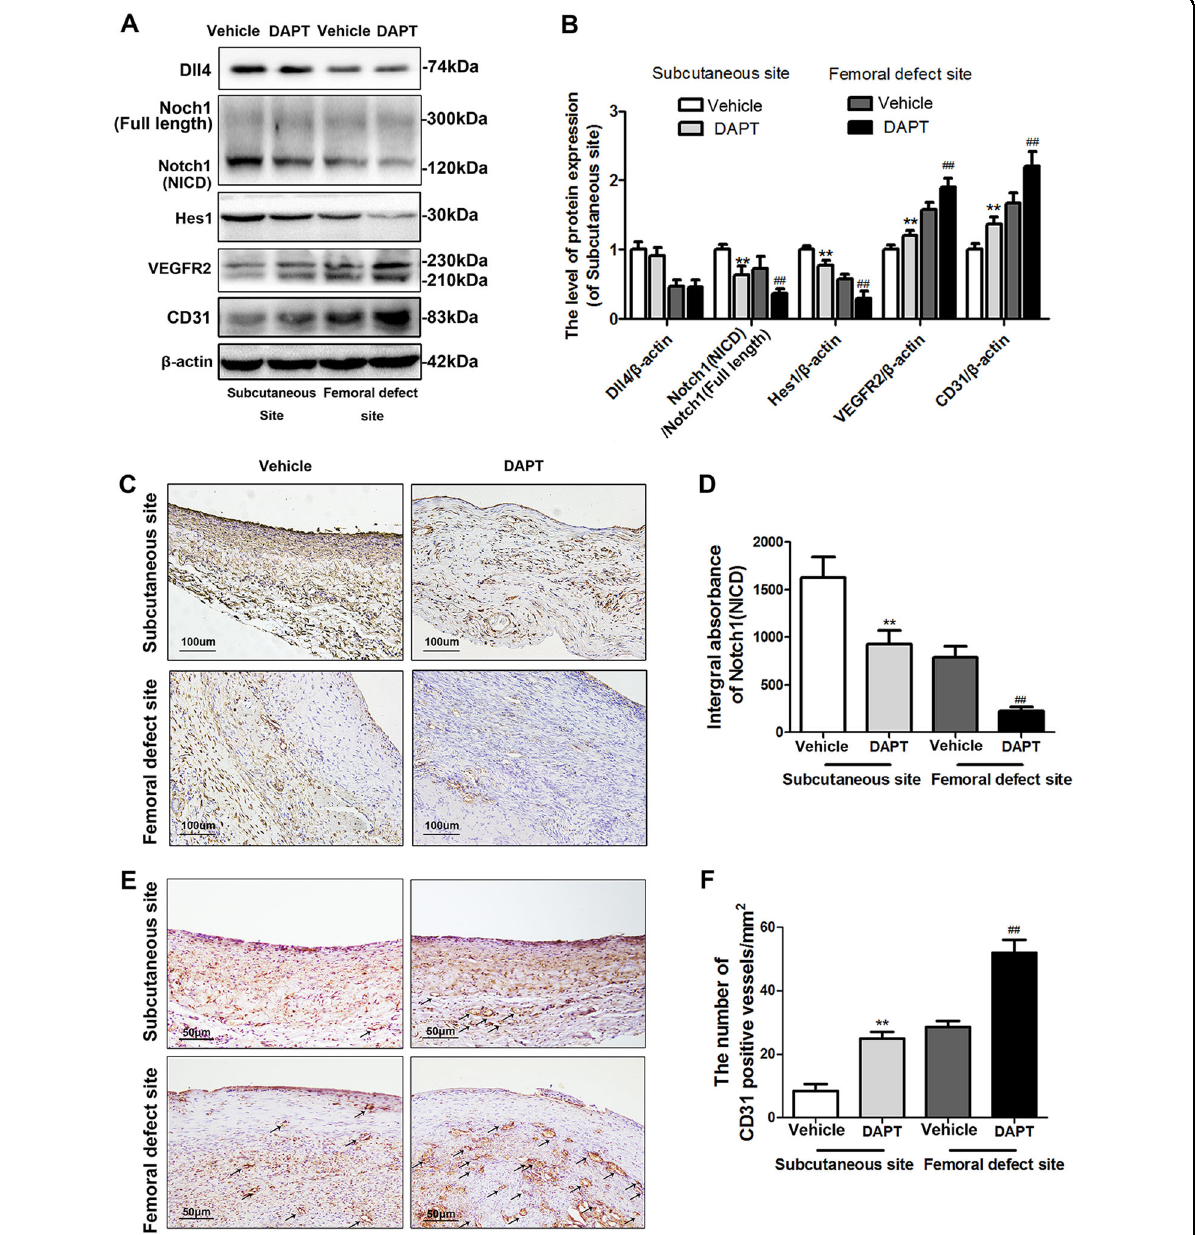
Fig. 4 Inhibition of Notch1 by DAPT promotes VEGFR2 and CD31 expression in the induced membrane in the subcutaneous site and femoral defect site. a – b Protein expression of Dll4, Notch1 (NICD), Hes1, VEGFR2, and CD31 in induced membrane derived from the subcutaneous site and femoral defect site with or without DAPT intervention. c , e Immunohistochemistry staining of Notch1 (NICD) and CD31 in induced membrane derived from the subcutaneous site and femoral defect site with or without DAPT intervention (scale bar: 50 μ m). d , f Quantitative results of the integral absorbance of the Notch1 and CD31-positive vessel density in induced membranes. The data in the fi gures represent averages ± S.D. Signi fi cant differences between the different groups are indicated as ** P < 0.01, compared with saline-treated induced membrane in the subcutaneous site; ## P < 0.01, compared with saline-treated induced membrane in the femoral defect site; for each group, n =